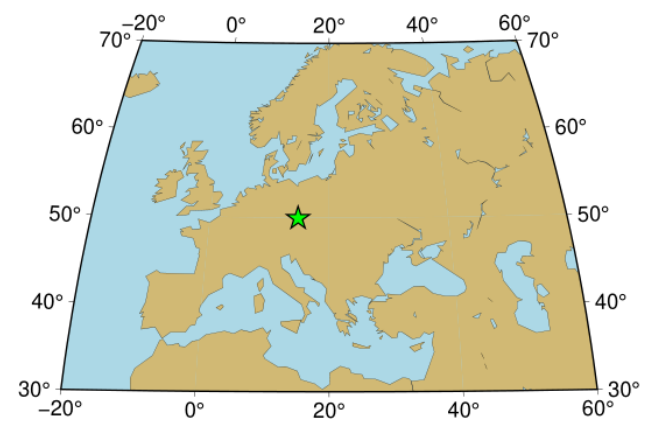
Mathematics 2020 , 8 , x FOR PEER REVIEW Figure 3 . Location of the GNSS baseline GOP6_GOP7 in Europe. Figure 3. Location of the GNSS baseline GOP6_GOP7 in Europe.